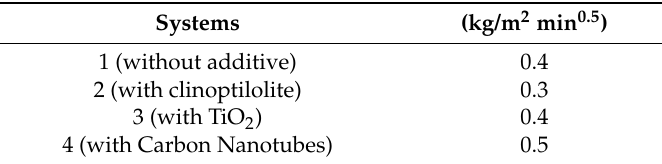
Table 3. Water absorption coefficient.